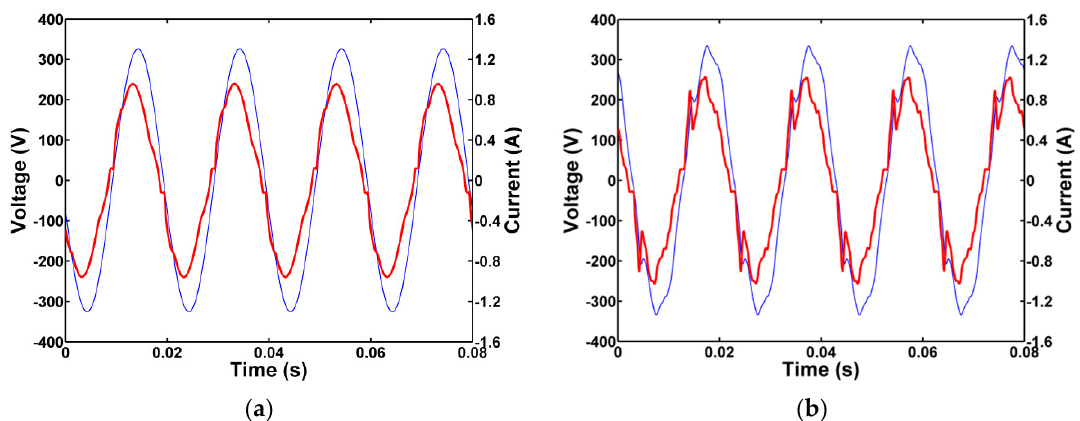
Figure 7. Waveforms of voltage and current for luminaire marked as LED1 for: ( a ) THD V = 0% and ( b ) THD V = 7.5%.